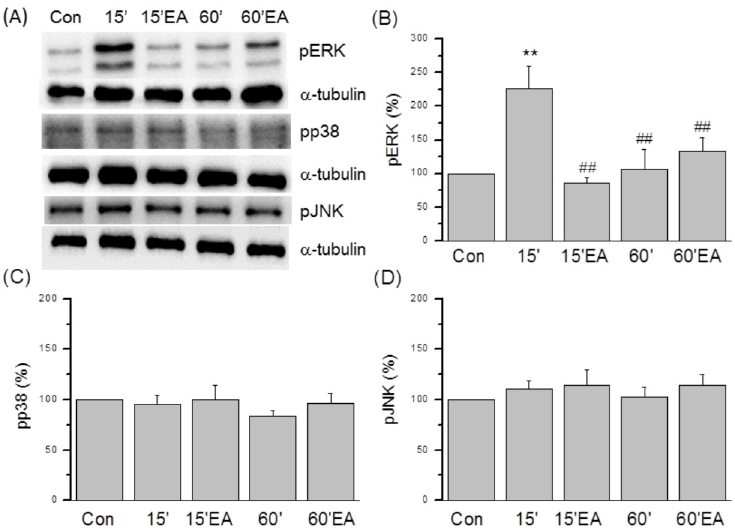
Fig 6. The expression of pERK, pp38, and pJNK proteins in L3-L5 DRG. (A) pERK, pp38, and pJNK kinases were measured by Western blot in lysates from DRG. (B) pERK expression was increased at 15 min after acid injection in FM mice and reversed by EA. No change in pERK expression was observed at 60 min after injection. (C) pp38 expression in DRG was not altered after acid injection and/or EA. (D) pJNK expression was not altered after acid injection and/or EA. α -tubulin expression was the internal control. Con = Control; 15 = 15 min after acid injection in FM group; 15EA = 15 min after acid injection in EA group EA. 60 = 60 min after acid injection in FM group; 60EA = 60 min after acid injection in EA group.